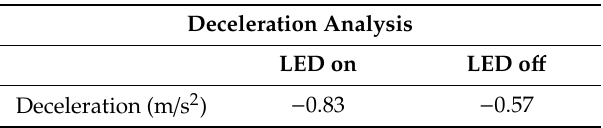
Table 3. Deceleration